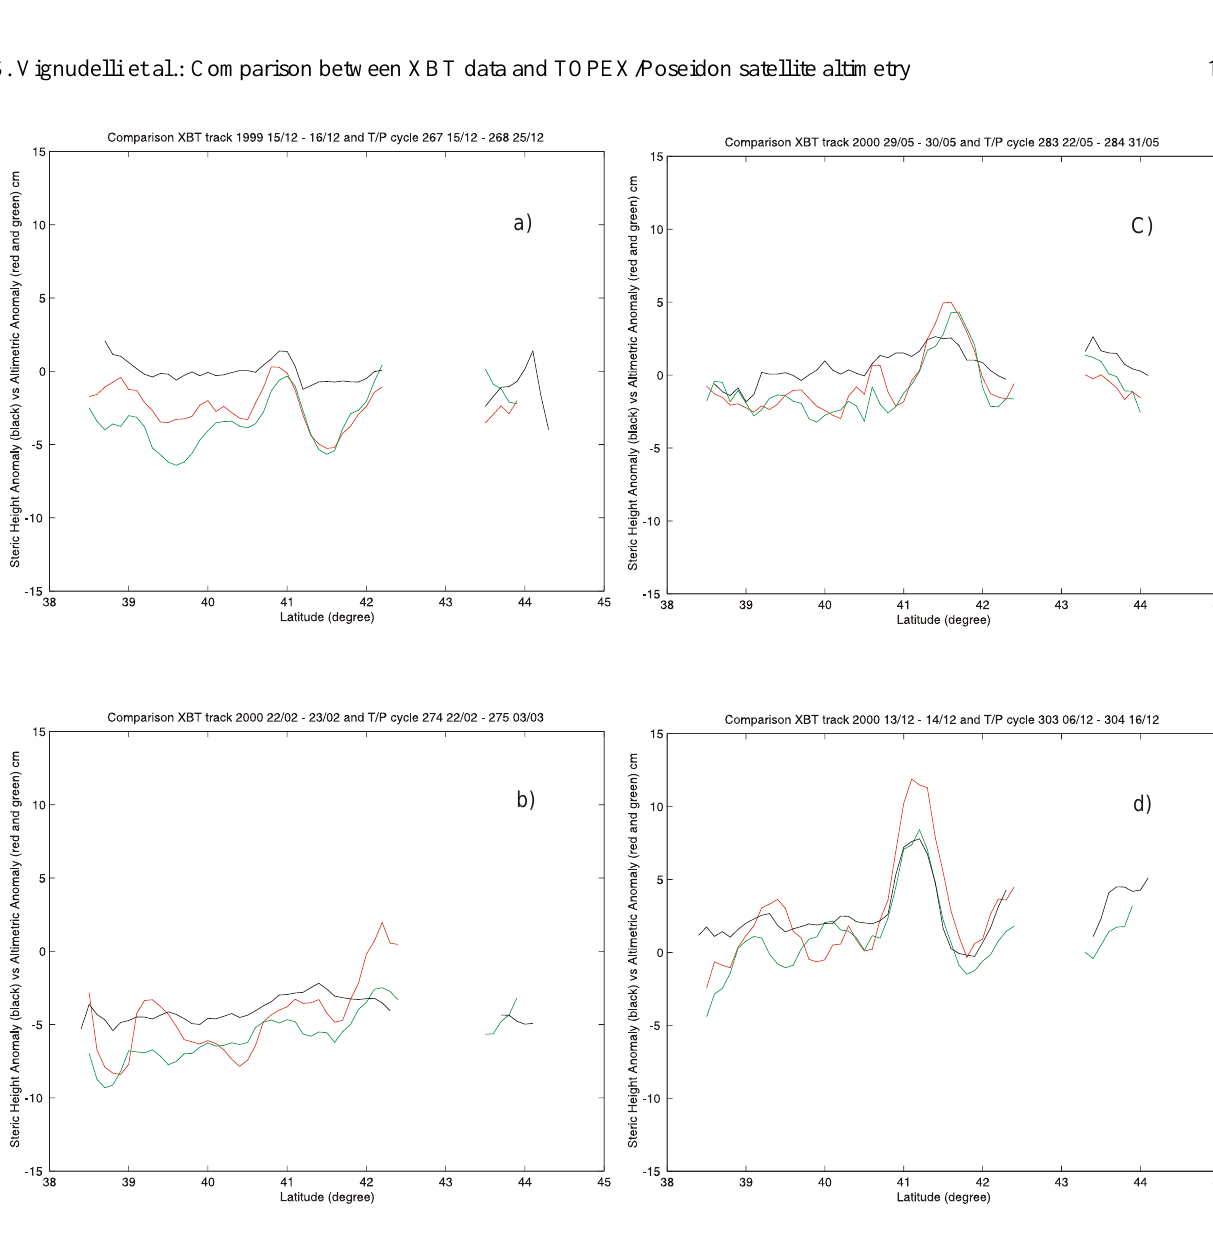
Fig. 9. Comparison of altimetric heights (green and red lines) and steric heights calculated from the XBT data and climatological salinity (black line). (a) 15–16 December 1999; (b) 22–23 February 2000; (c) 29–30 May 2000; (d) 13–14 December